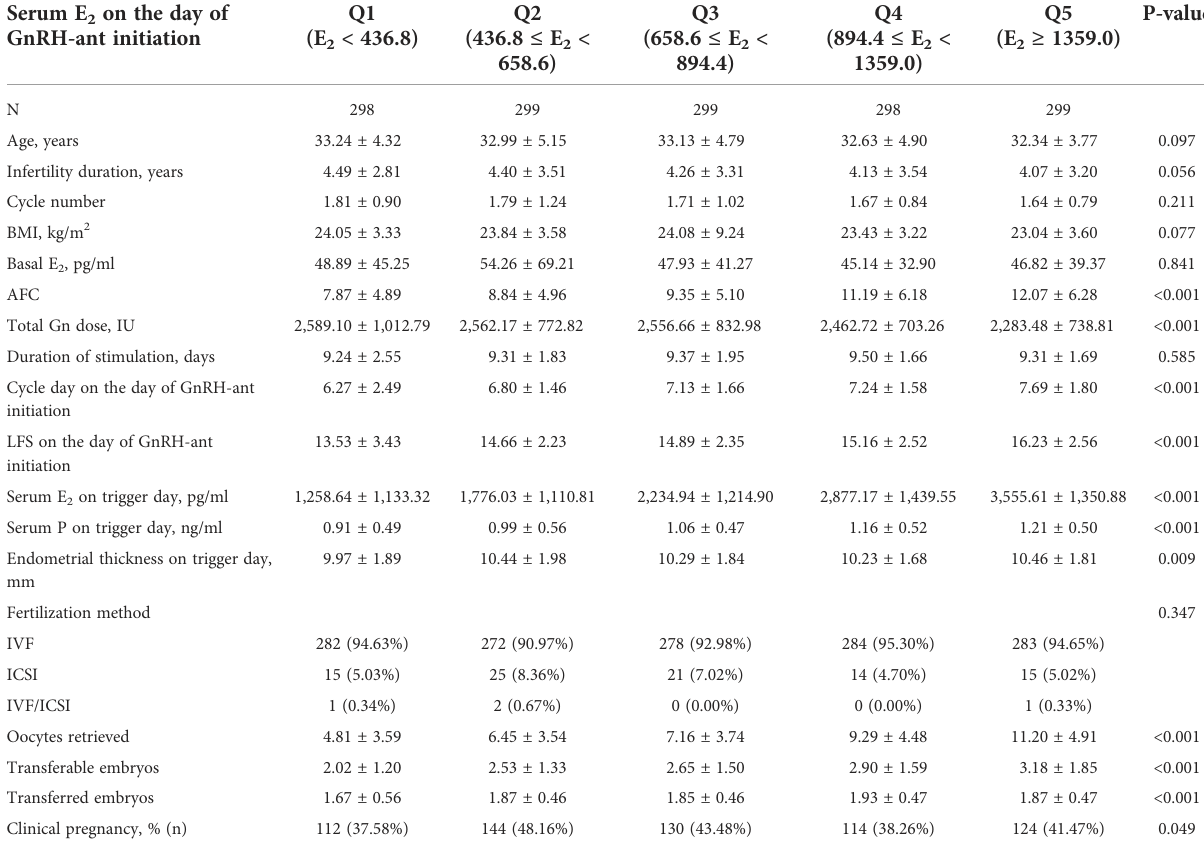
TABLE 1 Baseline data, cycle characteristics, and clinical pregnancy outcomes of the patients based on the serum E 2 levels on the day of GnRH- ant administration. Serum E 2 on the day of GnRH-ant